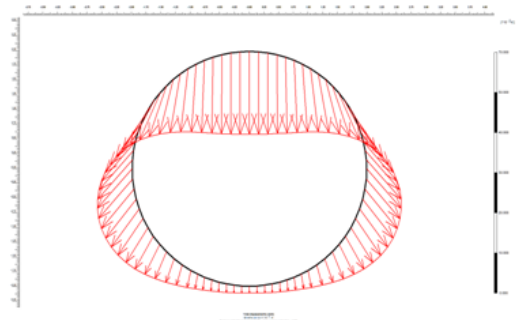
Figure 9. The diagram of shell displacements for